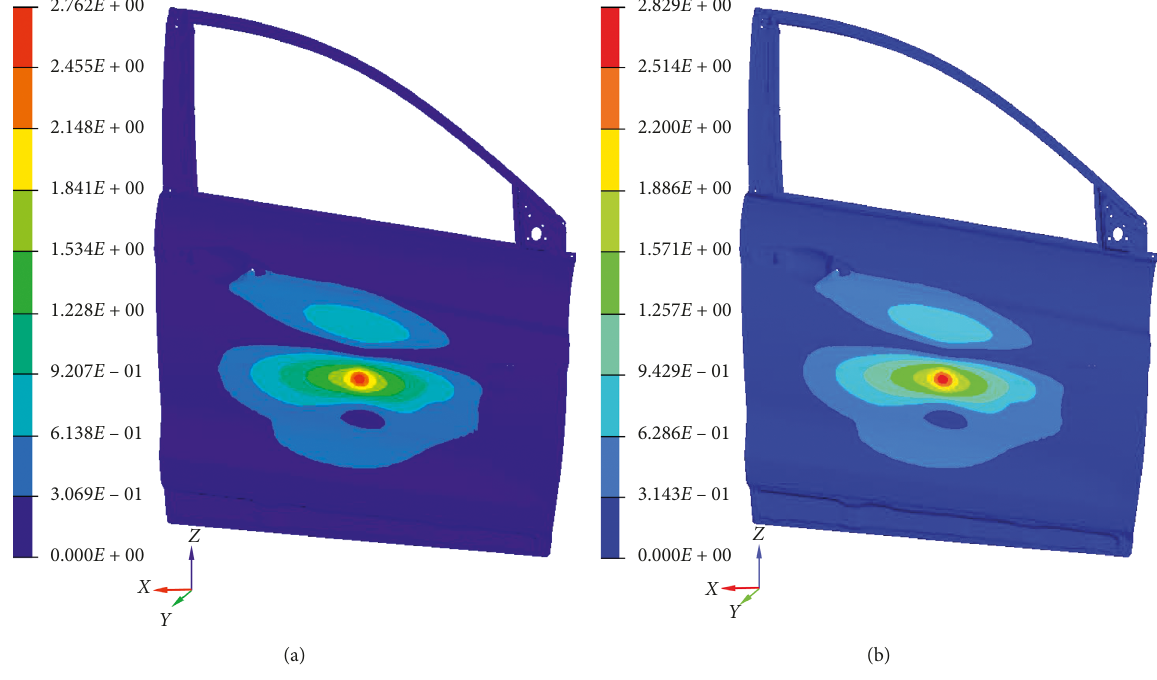
Figure 7: Displacement distribution before and after optimization under concentrated load. (a) Before optimization. (b) After